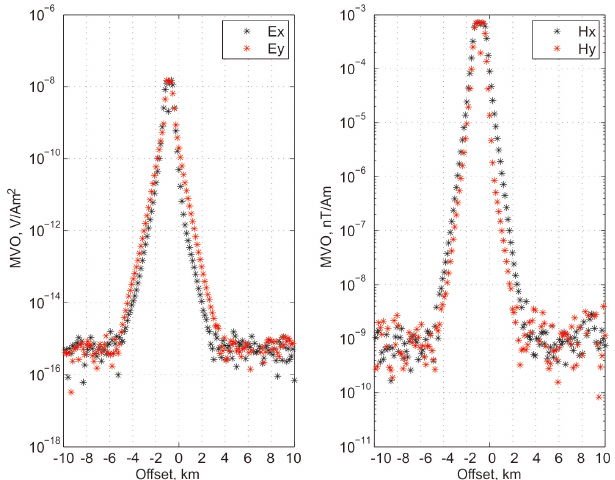
Figure 8. Magnitude versus offset for the E and H components (site: R19; frequency: 8Hz).